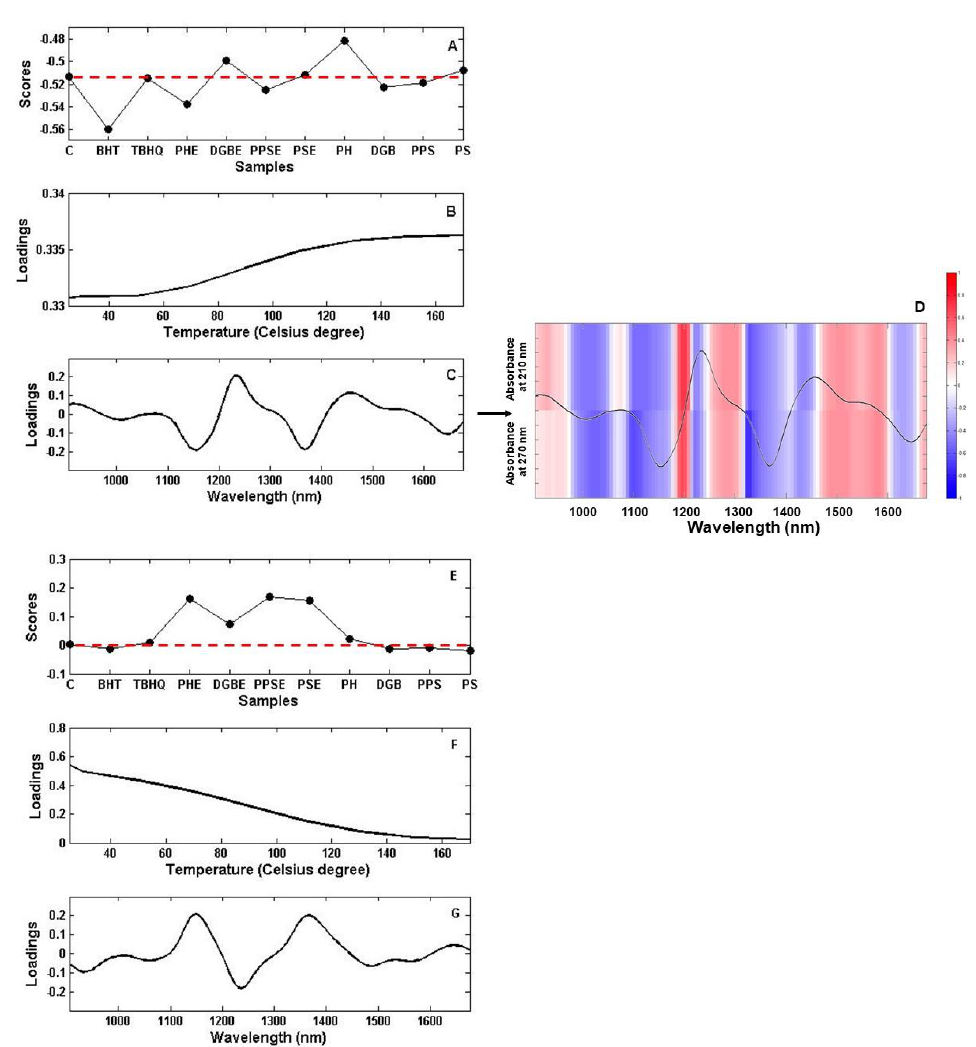
Figure 3. PARAFAC results. ( A) Scores on factor 1. ( B ) Loadings on factor 1 related to temperature. ( C ) Loadings on factor 1 related to spectral mode. ( D ) Correlation map through samples relating the NIR spectra at 150 °C versus the ultraviolet univariate result. ( E ) Scores on factor 2. ( F ) Loadings on factor 2 related to temperature. ( G ) Loadings on factor 2 related to spectral mode. C = Control (i.e., antioxidant-free soybean oil). BHT = butylated hydroxytoluene. TBHQ = tert-butylhydroquinone. PSE = Poppy seed extract. DGBE = Dehydrated goji berry extract. PPSE = Pumpkin seed extract. PHE = Provençal herbs extract. PH = Provençal herbs. DGB = Dehydrated goji berry. PPS = Pumpkin seed. PS = Poppy seed.